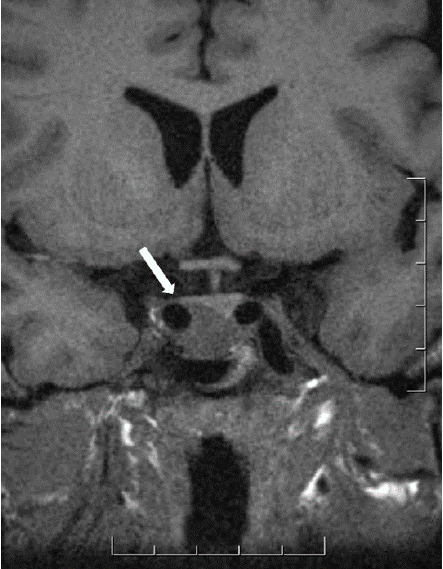
Figure 6. Magnetic resonance imaging of mammosomatotroph tumor. The sella turcica is enlarged and contains a tumor that compresses the normal gland upwards and to the left; the tumor infiltrates laterally to invade the right cavernous sinus (white arrow).